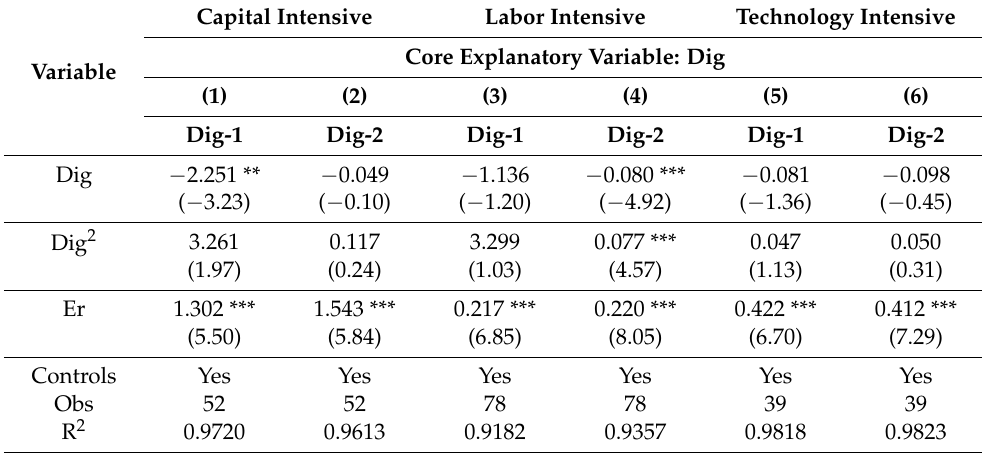
Table 5. Heterogeneity analysis